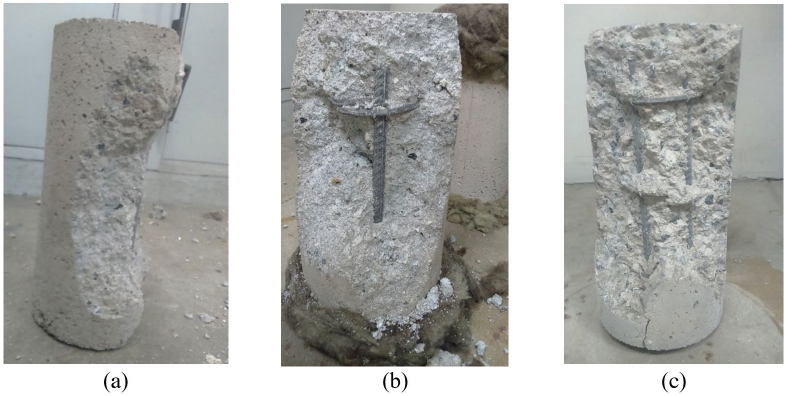
Figure 6. Spalling of specimens: a) CP1_90_2 (408 ºC); b) CP2_90_2 (400 ºC); c) CP1_120_3 (422 ºC).